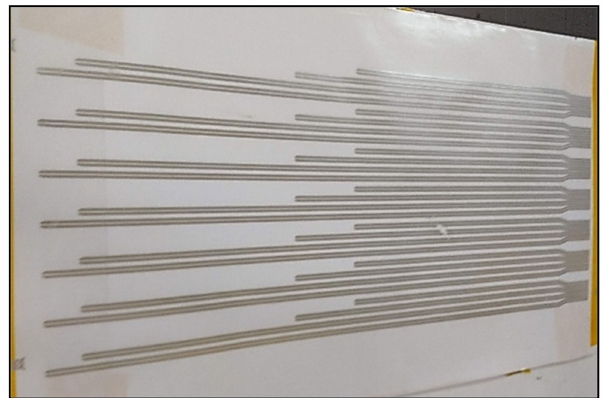
Figure 4. Pattern screen-printed with conductive silver ink on the polyurethane